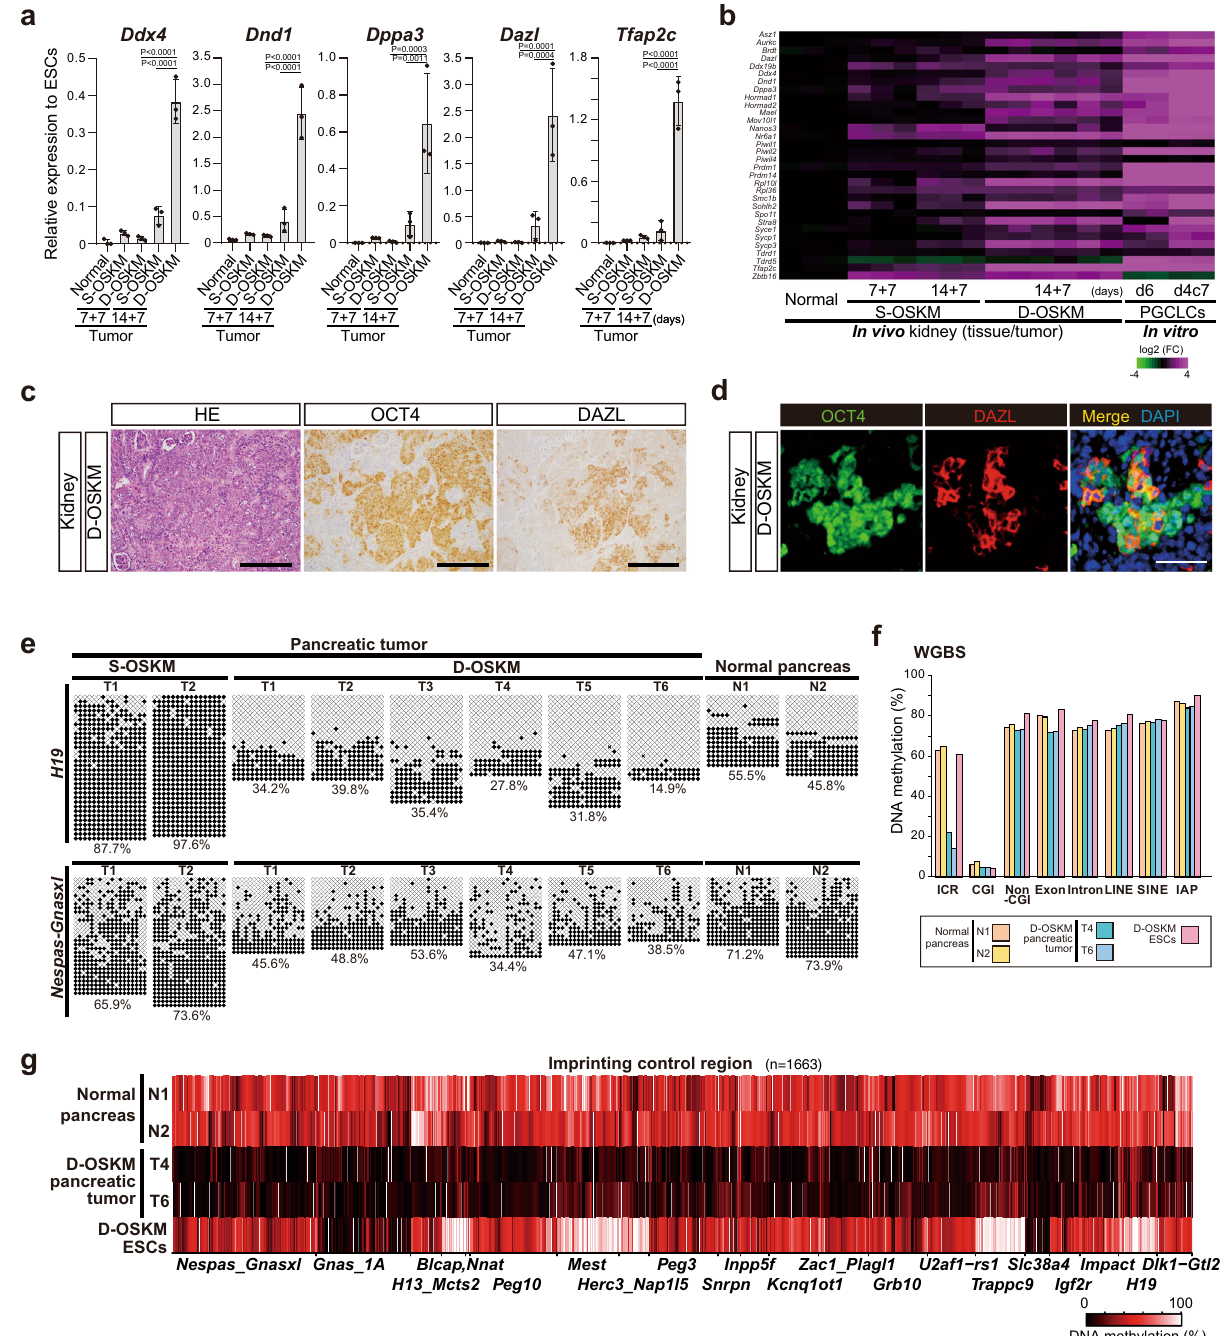
Fig. 2 PGC-associated signatures in D-OSKM-induced tumors. a qRT-PCR analyses of PGC-related gene expression in S-/D-OSKM kidney tumors. Data are presented as means± SD of biological triplicates. Relative expression levels to ESCs are shown (one-way ANOVA and Dunnett ’ s multiple-comparison test, two-sided). b Heatmap showing relative expression of germ line-related genes 73, 74 in S-/D-OSKM kidney tumors. PGC-like cells (PGCLCs) were derived from ESCs as described previously 39, 74 . Color range is shown using a log 2 scale. c Representative histological images and immunostaining for OCT4 and DAZL of D-OSKM kidney tumors. Scale bars: 200 μ m. d Immuno fl uorescence staining for OCT4 and DAZL in D-OSKM kidney tumors. Scale bars: 50 μ m. e DNA methylation analysis of individual CpG sites at the H19 ICR and Nespas-Gnasxl ICR in D-OSKM pancreatic tumors. f DNA methylation percentage at various genetic elements in D-OSKM pancreatic tumors, measured by whole-genome bisul fi te sequencing (WGBS). CGI, CpG island; non- CGI, non-CpG island. g Heatmap showing global ICR methylation in D-OSKM pancreatic tumors, as determined by MethylC-seq analysis. n indicates the number of examined CpG